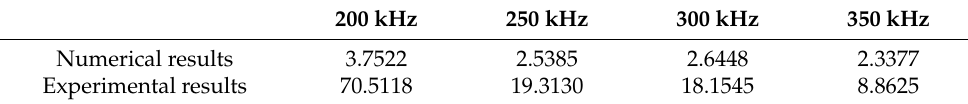
Table 7. Absolute distance of experiment and simulation under different center frequencies. 200 kHz 250 kHz 300 kHz 350